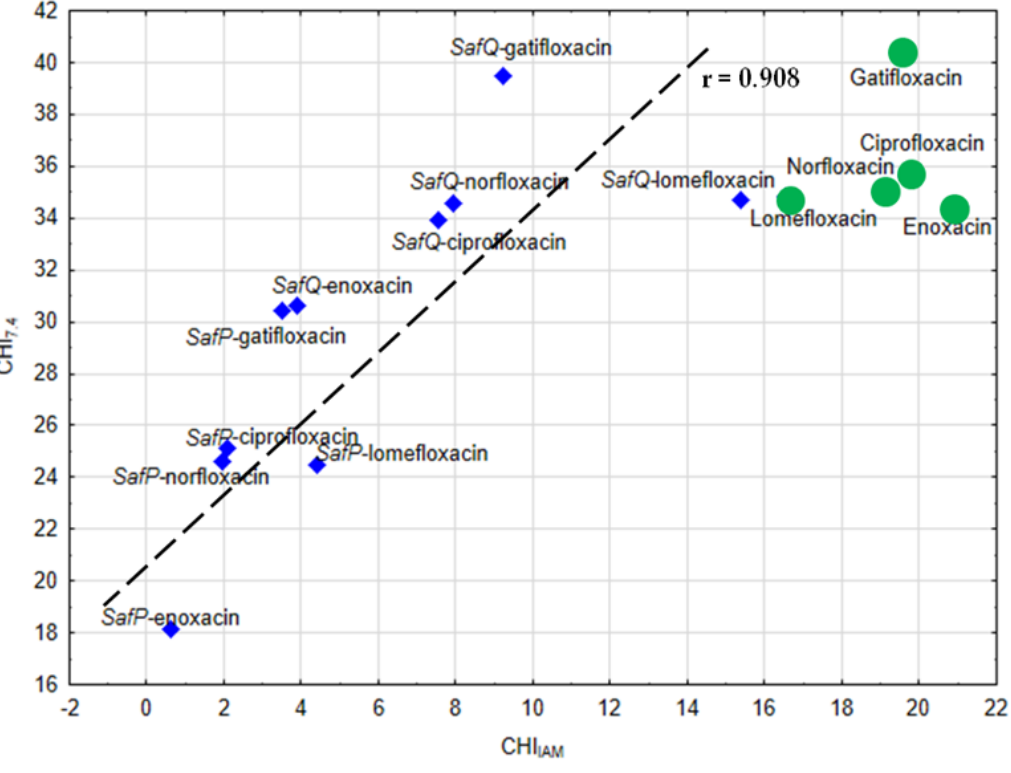
Figure 2. Scatterplots comparing CHI pH7.4 and CHI IAM parameters determined for parent fluoroquinolones (FQs; marked green) and Safirinium derivatives (marked blue).